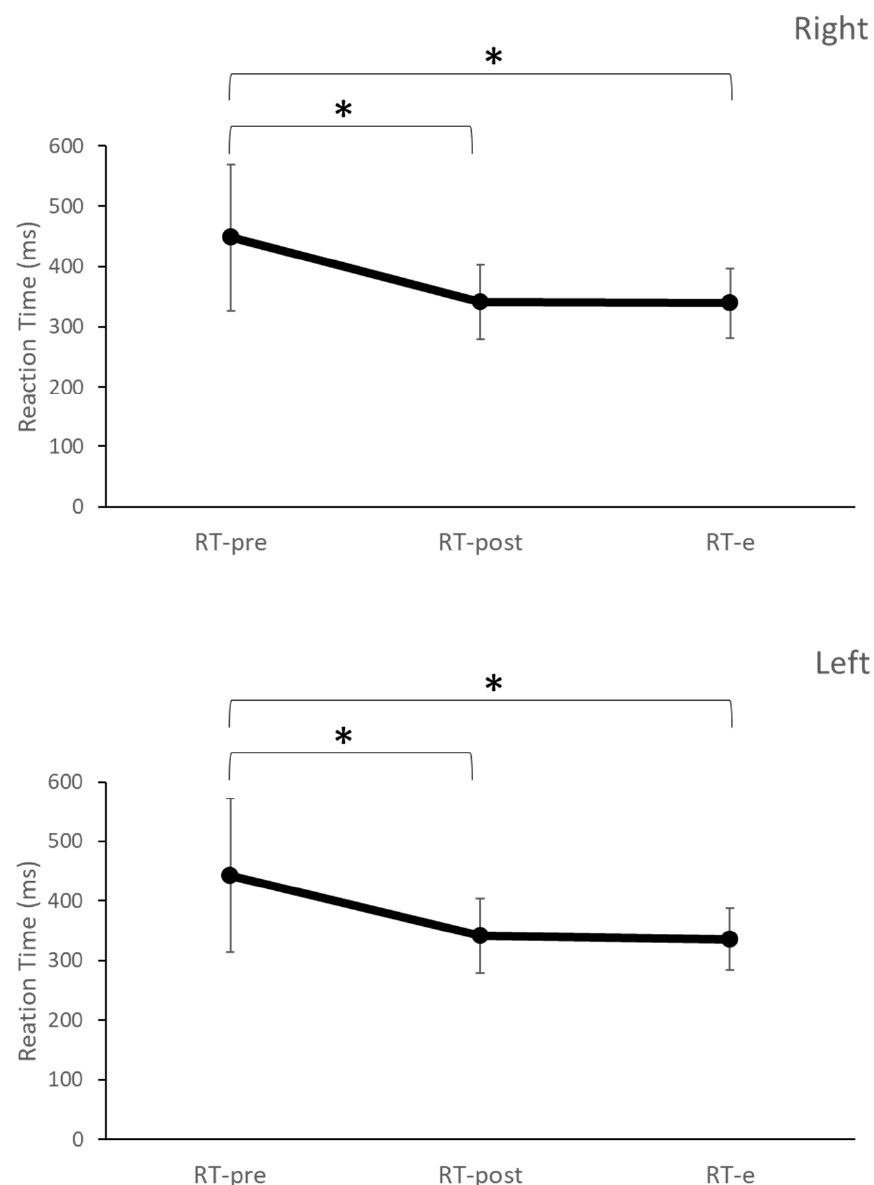
Figure 4. Mean ± SD reaction time from the 25 subjects from the experimental group during before TI training (RT-pre), after TI training (RT-post), and follow-up evaluation (RT-e) for each hand. * Statistical significance with p < 0.05.